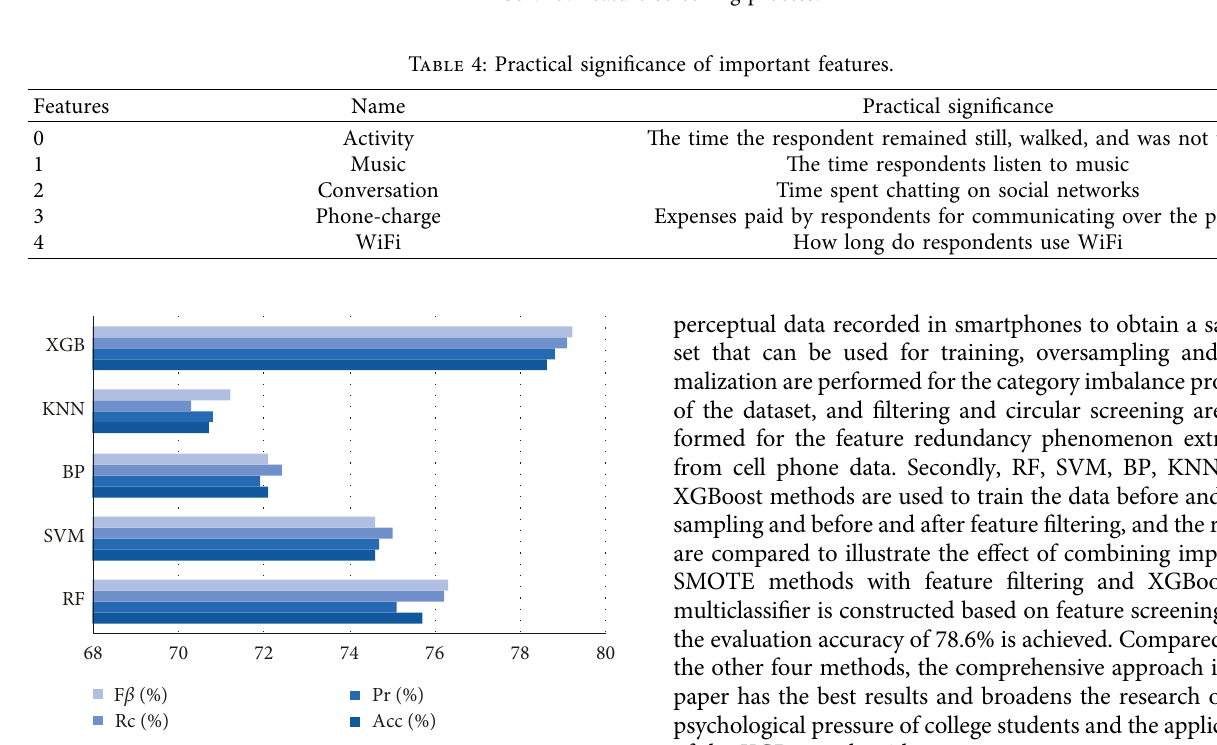
Figure 4: Comparison of final training results.